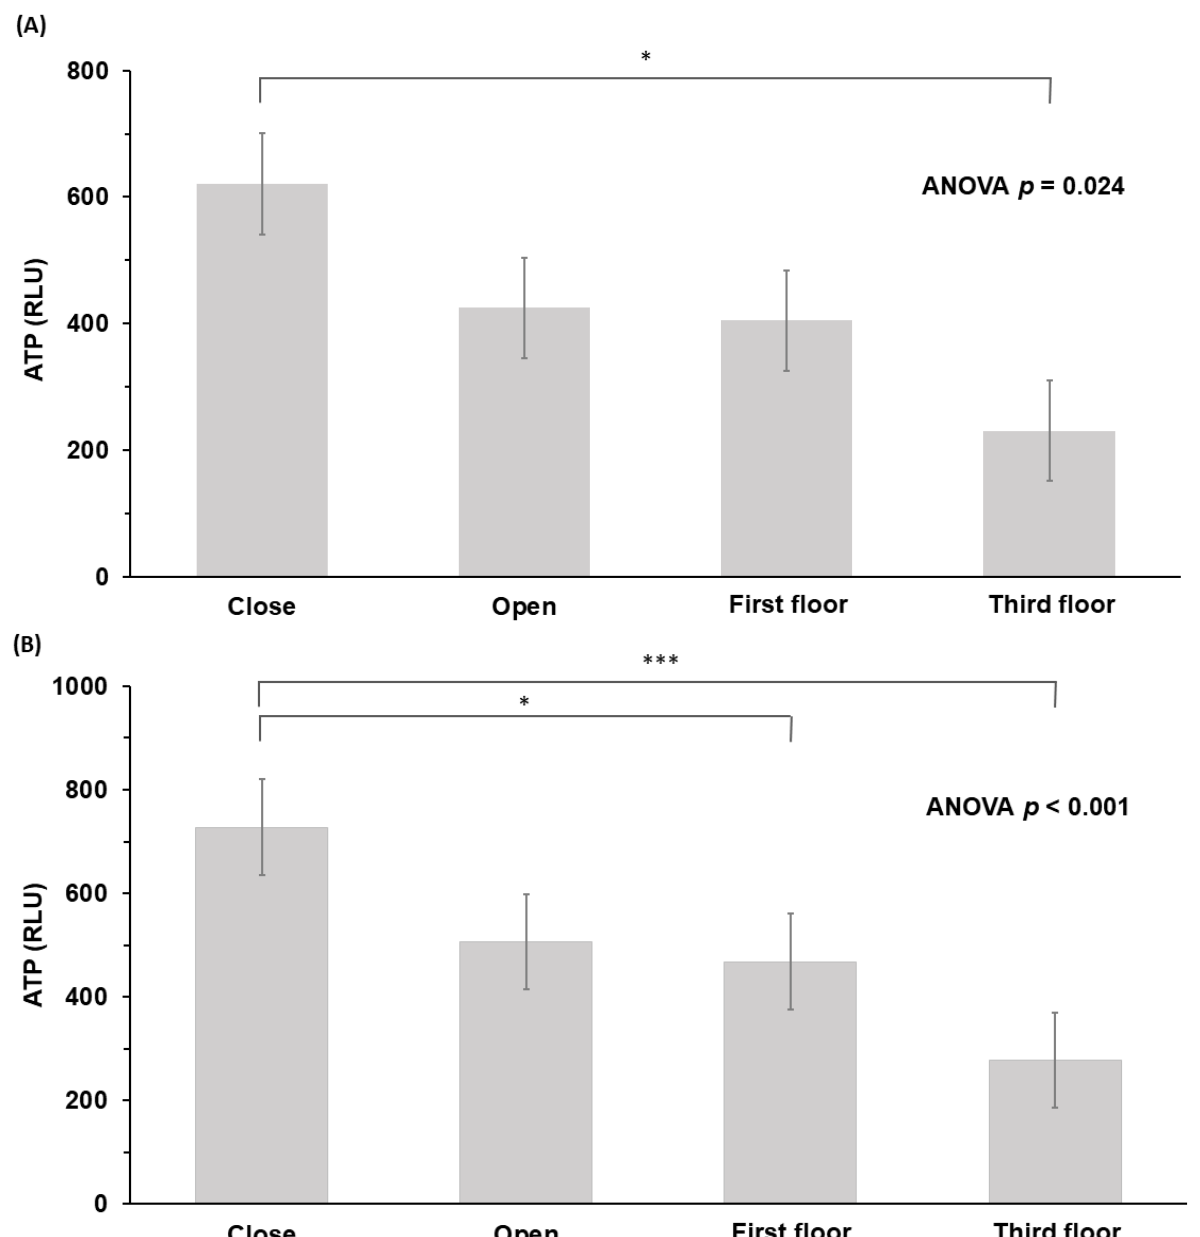
ATP, adenosine triphosphate; RLU, relative light unit; SD, standard deviation . a * p < 0.05, *** p < 0.001.